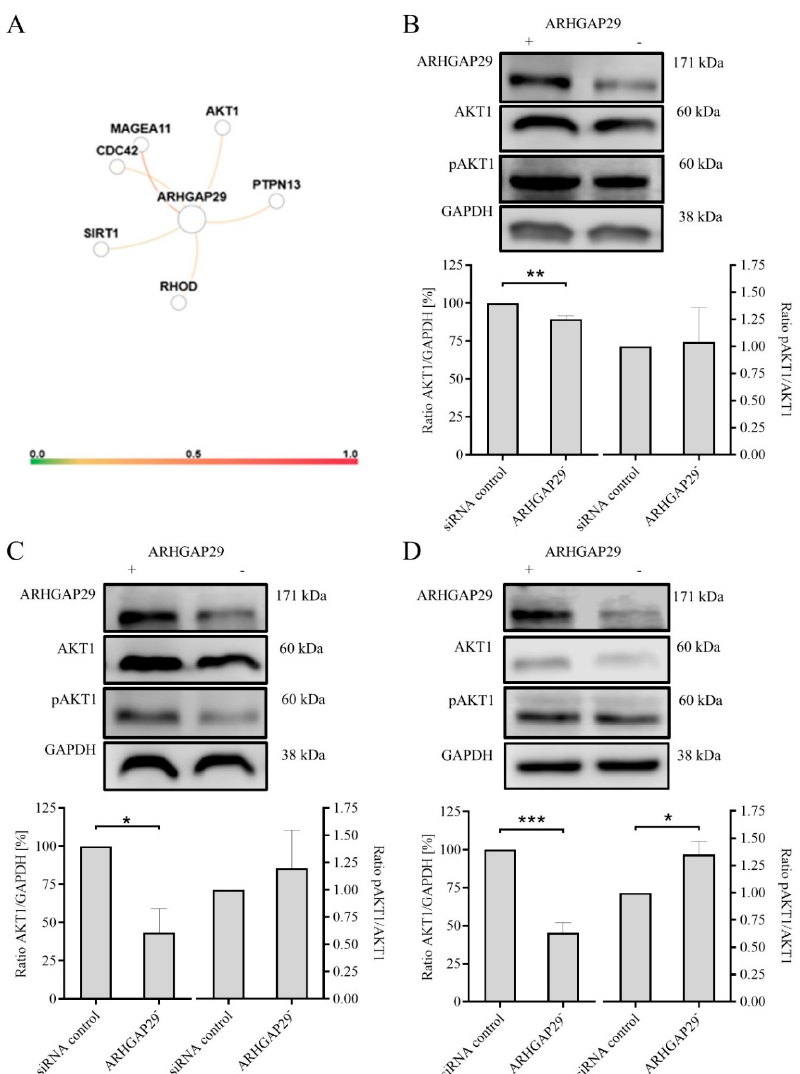
Figure 4. ( A ) Probability of interaction of Rho GTPase activating protein 29 (ARHGAP29) with AKT1, SIRT1, PTPN13, CDC42, MAGEA11, and RHOD. In silico analyses were carried out using the GIANT web server (Genome-wide Integrated Analysis of gene Networks in Tissues, provided by HumanBase, https://hb.flatironinstitute.org/, last accessed on 26 July 2019). A value of 0.1 was chosen as a minimum confidence interval to investigate interactions. The maximum number of genes considered was seven. The color of the connecting lines between interaction partners reflects possible interactions from 0 (no interaction) to 1 (high probability of interaction). The expression of AKT1 and the pAKT1/AKT1 ratio in MCF-7-EMT ( B ), T-47D-EMT ( C ), and HCC1806 ( D ) breast cancer cells after knock-down of ARHGAP29 expression are shown. Breast cancer cells were transiently transfected with ARHGAP29-specific siRNA or non-targeting control siRNA (control). The expression of AKT1 was determined using Western blot analysis and normalized to GAPDH expression using at least three biological and technical replicates. The pAKT1 / AKT1 ratio was analyzed as the quotient of pAKT1 versus AKT1 expression. Representative blots for ARHGAP29, AKT1 and pAKT1 are shown. Mean ± SEM values are given. Significance was determined with the help of unpaired t-tests; (***) p < 0.001; (**) p < 0.01; (*) p <